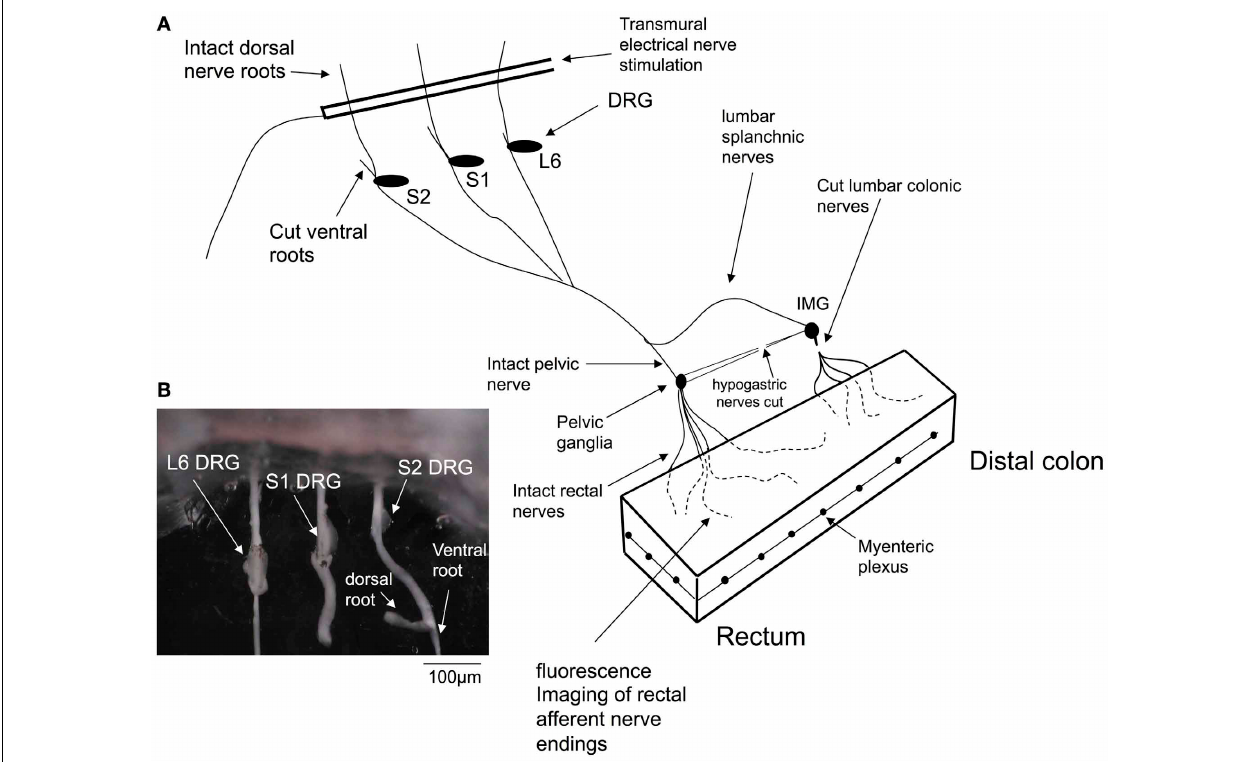
FIGURE 1 | Diagrammatic representation of the in vitro preparation used to image dynamic changes in intracellular calcium from spinal afferent nerve terminals in response to maintained circumferential stretch of the isolated mouse colon and rectum. Panel (A) , shows a cartoon of the preparation used, where L6 to S2 DRGs were removed from either left or right side of the spinal cord and complete extrinsic neural continuity was retained with the large